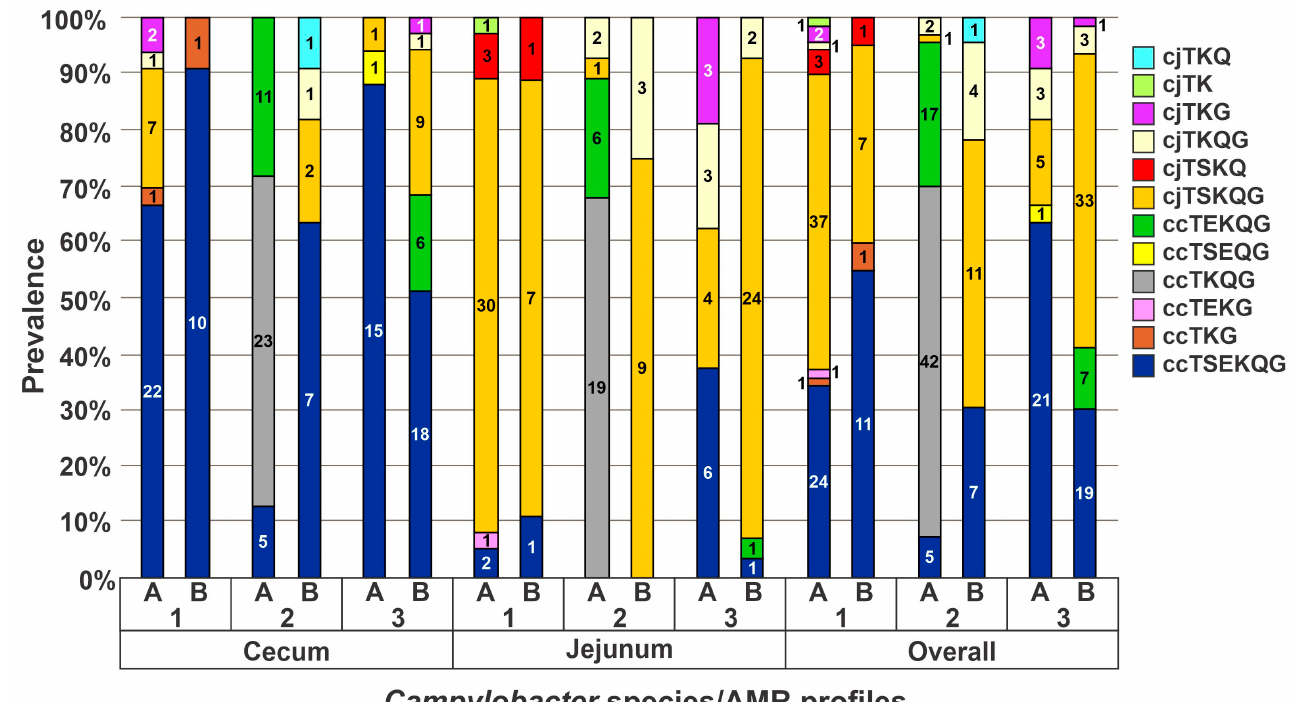
Figure 3. Campylobacter species and AMR profile pre- and post-treatment in isolates from the cecum and the jejunum of the three turkey flocks. Distribution of Campylobacter species/AMR profiles among isolates from the cecum and jejunum before (A) and after (B) treatment of the flocks which underwent treatment with copper sulfate (flock 1) or penicillin/gentamicin (flocks 2 and 3).